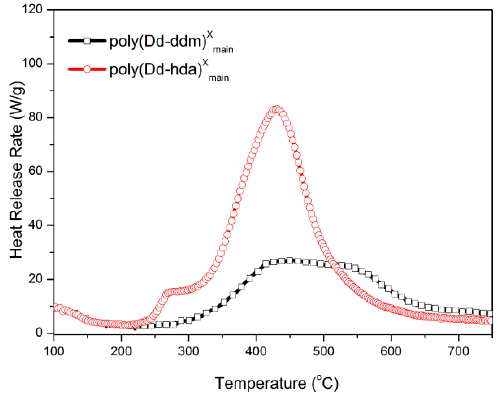
Figure 8. Heat release rate (HRR) versus temperature for poly(Dd-hda) Xmain and poly(Dd-ddm) Xmain .